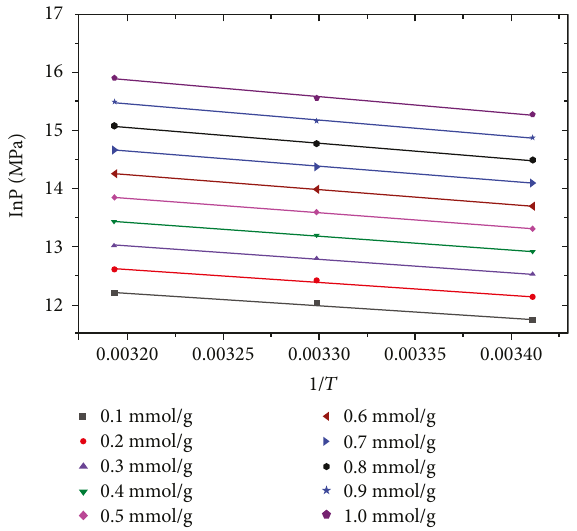
Figure 4: Relationship between ln P and 1/ T under the conditions with di ff erent molar adsorption amount.